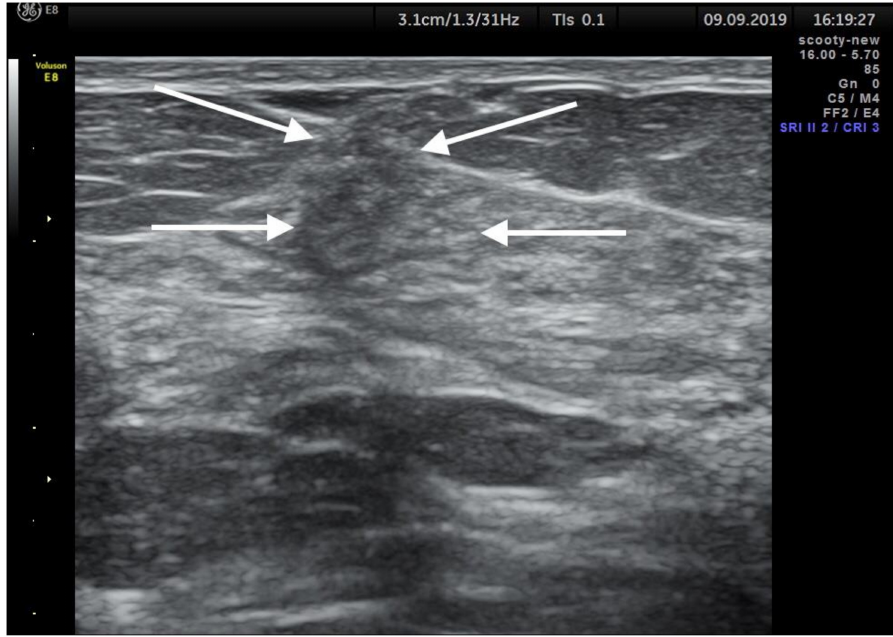
Figure A2. Ultrasound image of the BI-RADS-US class 4b, diabetic mastopathy-type lesion measuring 11 × 8 × 9 mm in a 37-year-old